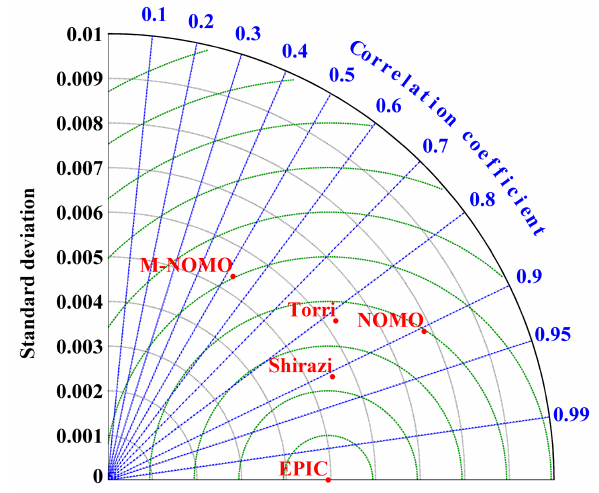
Figure 2. Taylor diagram used to compare estimated K values among